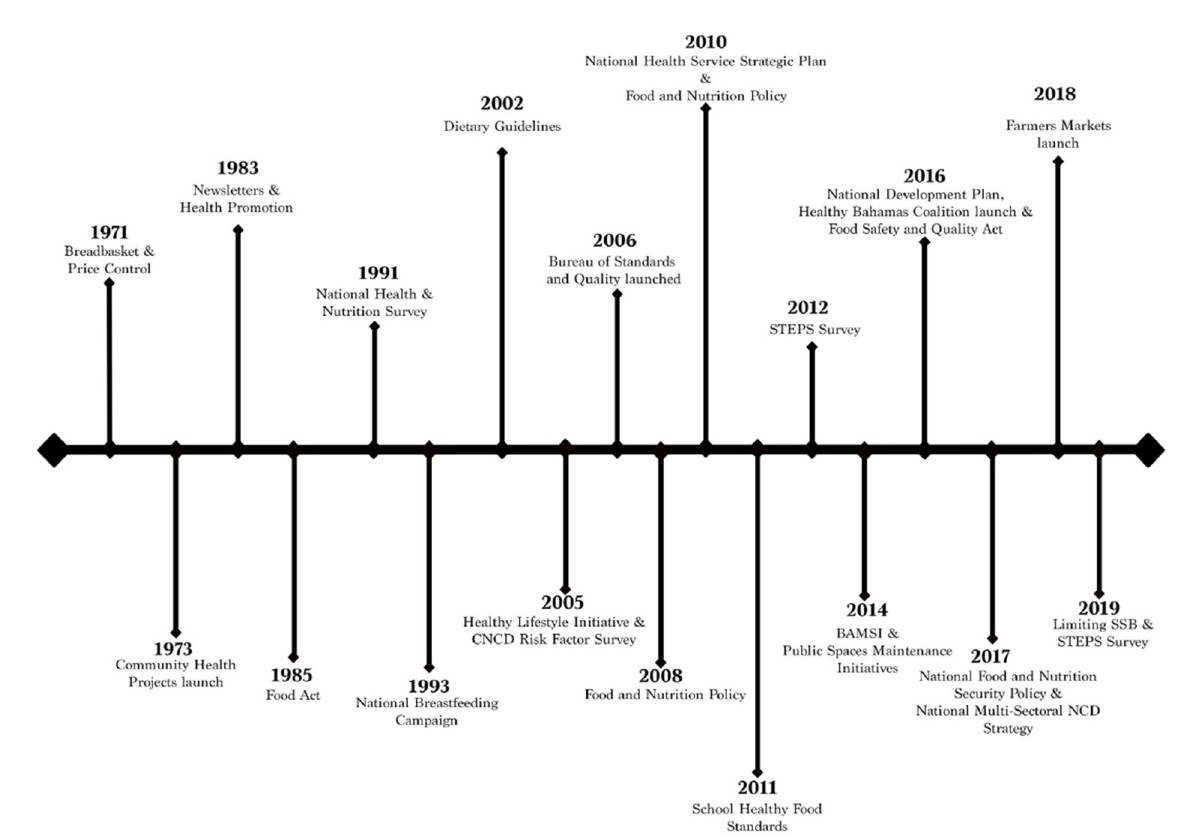
FIGURE3 Timeline of policy responses to the prevalence of obesity in The Bahamas. The timeline shows a range of national policies and population- and community-level interventions implemented after the 2000s. In most instances, documents did not specify how long policies were in